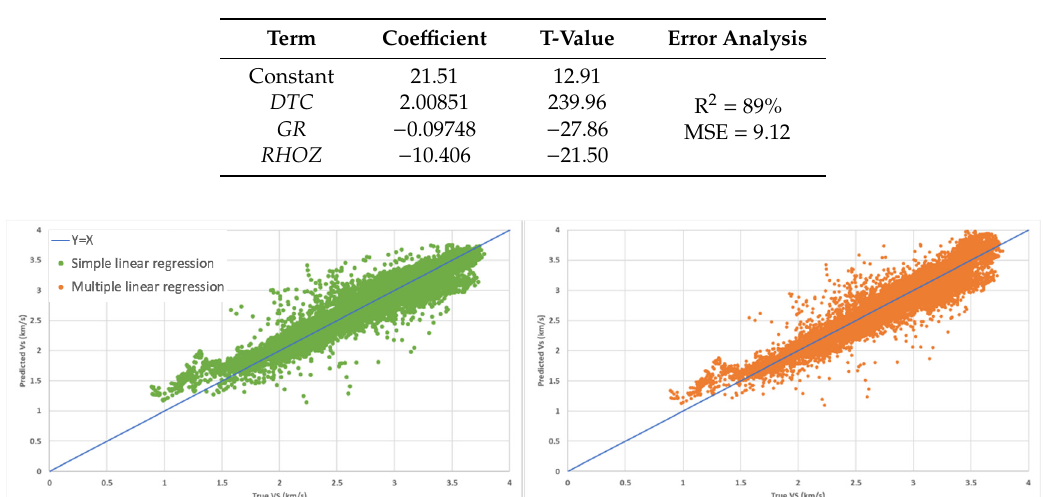
Table 2. Simple linear regression model properties.